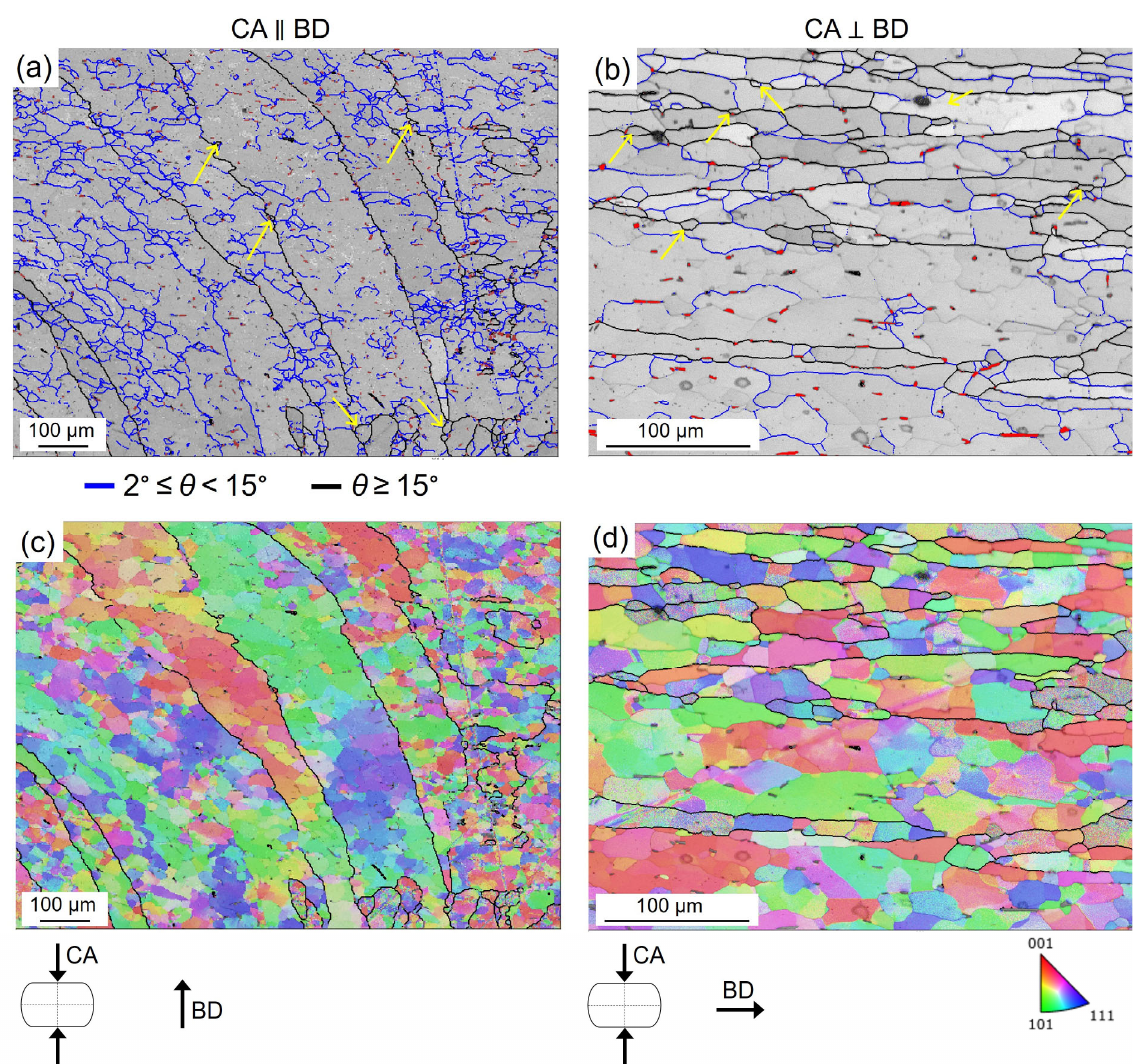
Figure 4. EBSD grain boundary misorientation maps superimposed with image quality (IQ) maps ( a , b ) and GROD ‐ axis maps ( c , d ) for the LPBF ‐ fabricated builds subjected to hot compression at 1000 °C/0.0013 s − 1 up to a true strain of 0.8. CA and BD refer to compression axis and building direction, respectively. CA was either parallel ( a , c ) or perpendicular ( b , d ) to the BD. The blue and black lines mark low ‐ angle grain boundaries with misorientations ( θ ), 2° ≤ θ < 15° and high ‐ angle grain bound ‐ aries with θ ≥ 15°, respectively. Small red regions in ( a ) and ( b ) exhibit C14 Laves phase precipitate particles. The arrows in ( a ) and ( b ) indicate a few small, equiaxed grains formed at the pre ‐ existing grain boundaries.